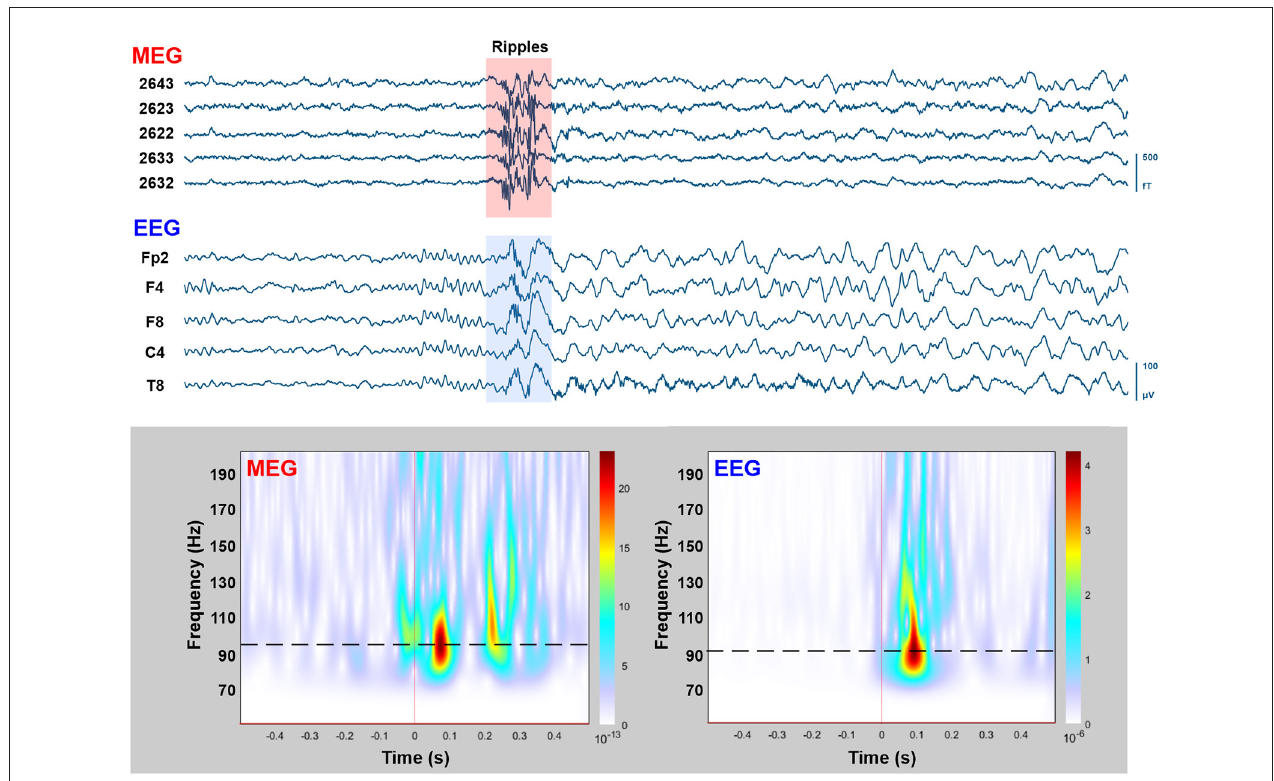
FIGURE 3 | MEG/EEG recordings with HFOs overlapping on IEDs. Upper: Time-traces (10s) of simultaneously recorded MEG (five planar gradiometers) and conv-EEG (five monopolar montage electrodes) recordings. Segment with HFOs in the ripple frequency band (80–200Hz) overlaid on IEDs is highlighted. Lower: Time-frequency analysis (Morlet wavelets; 50–200Hz) for the highlighted MEG and EEG segments (1s duration). Peak frequency of ripple-event is displayed on time-frequency plots with